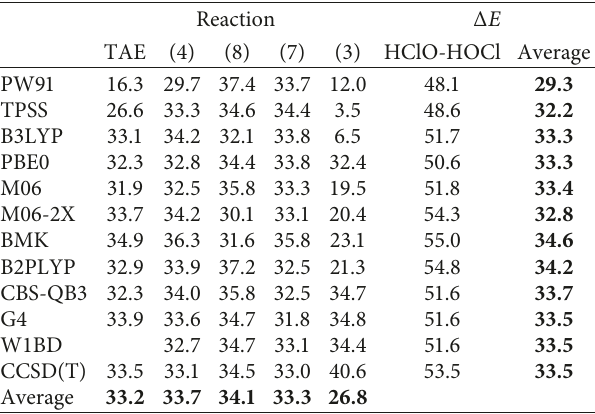
Table 3: Standard enthalpies of formation of HClO (in kcal/mol) obtained from the reaction of atomization and reactions (3), (4), (7), and (8) are reported in the first five columns of the table. The energy difference between HClO and HOCl (without zero-point energies) is shown in the sixth column. The last column shows the average of the enthalpies of formation calculated using reactions of atomization, (4), (7), and (8). Values obtained with reaction (3) were not included in this average. The last file shows the averages, for each reaction, of the values of the enthalpy of reaction obtained with each method, excluding the PW91 and TPSS